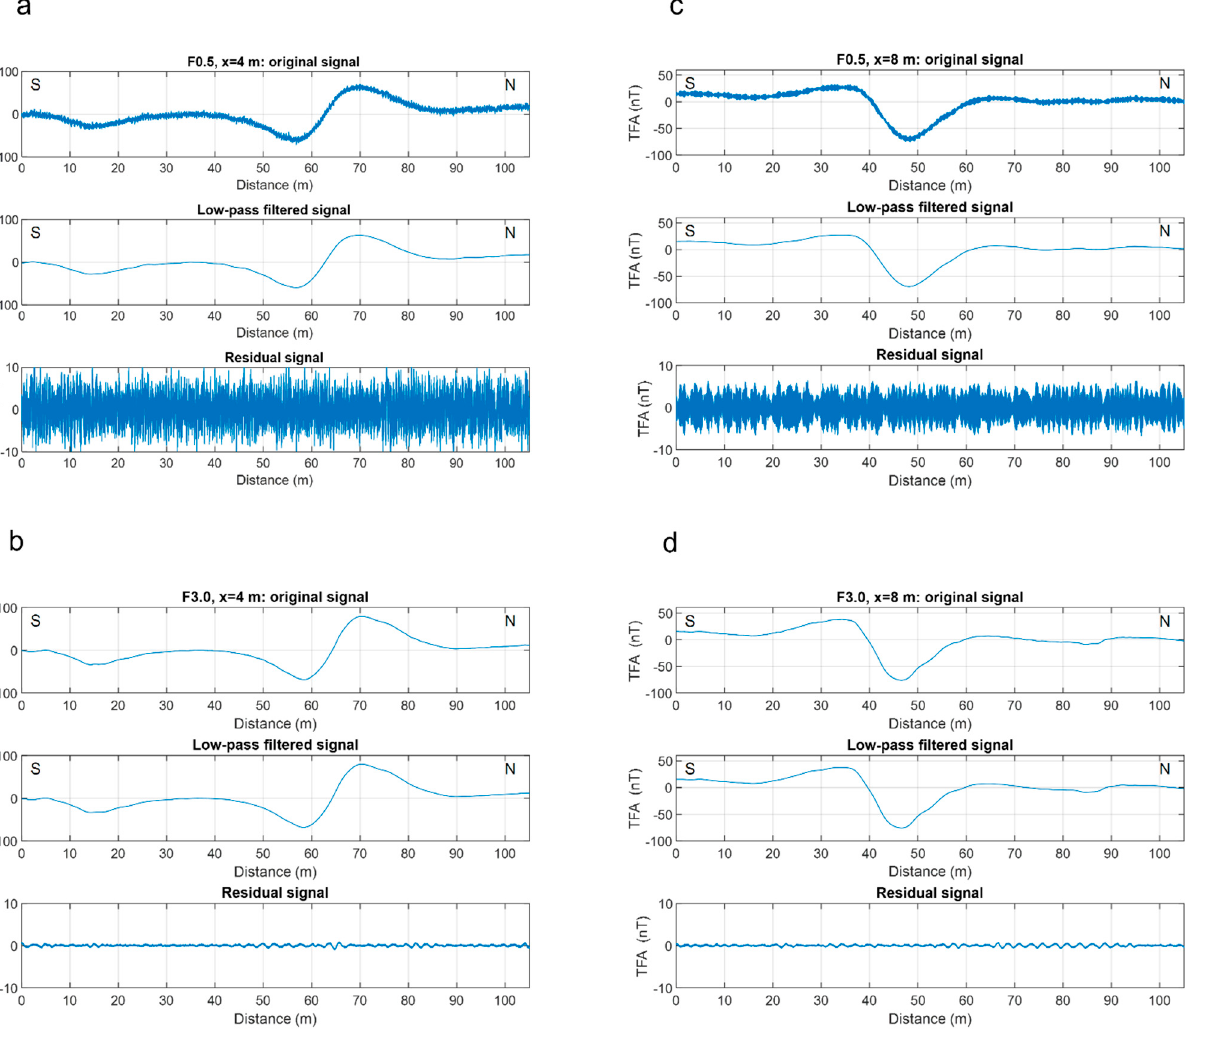
Figure 6. Application of a 0.5 Hz Hanning-window low-pass filter along two profiles for F0.5 and F3.0 datasets. The three plots in each panel show the raw data, the filtered data, and their difference (the residual signal). ( a ) Profile at x = 4 m; the magnetometer–UAV distance was 0.5 m; ( b ) profile at x = 4 m; the magnetometer–UAV distance was 3 m; ( c ) profile at x = 8 m; the magnetometer–UAV distance was 0.5 m; ( d ) profile at x = 8 m; the magnetometer–UAV distance was 3 m. The difference in amplitude between the residual signal in ( a , c ) demonstrates the heading error, as the two profiles were acquired while flying in opposite directions. “TFA” stands for “total-field anomaly.”